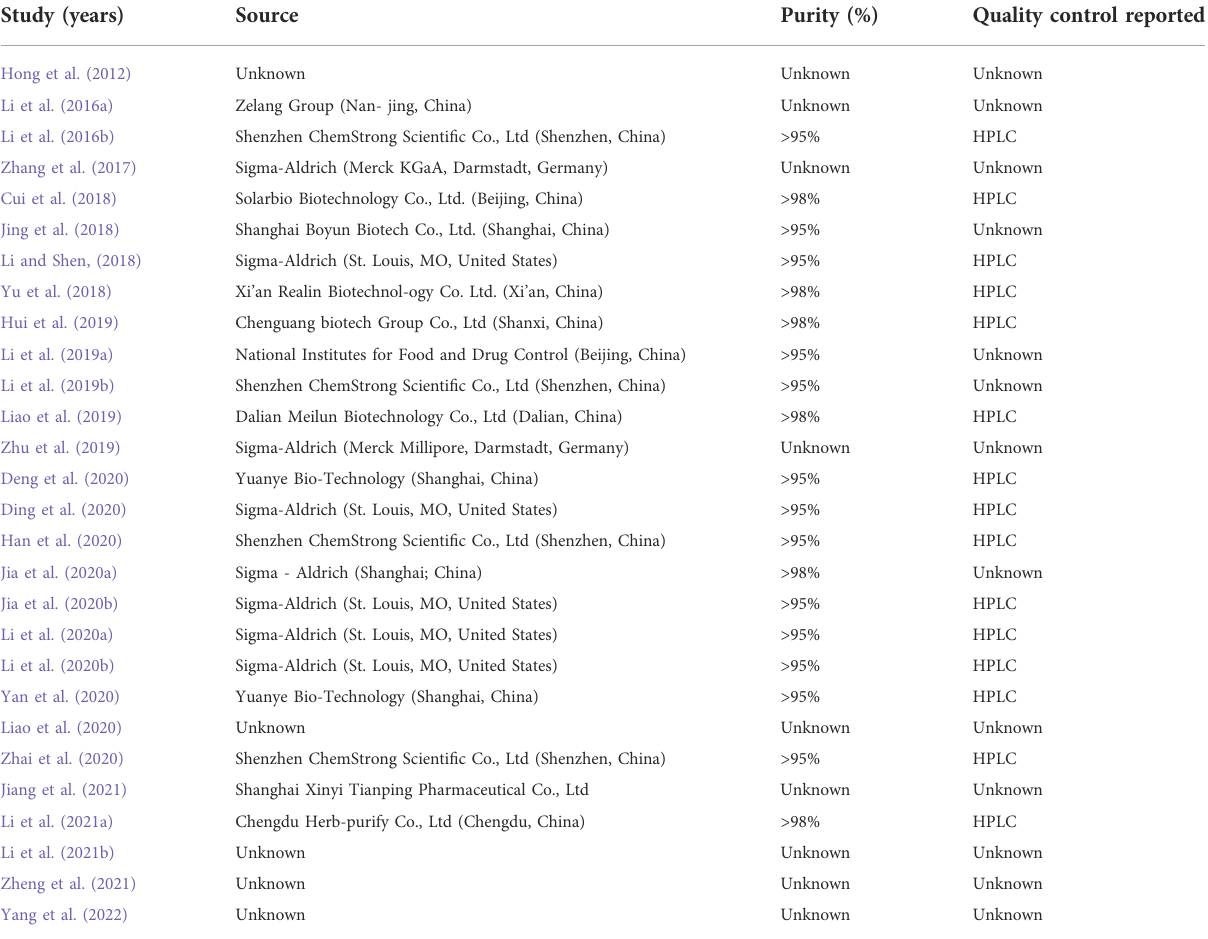
TABLE 1 Information of berberine of each